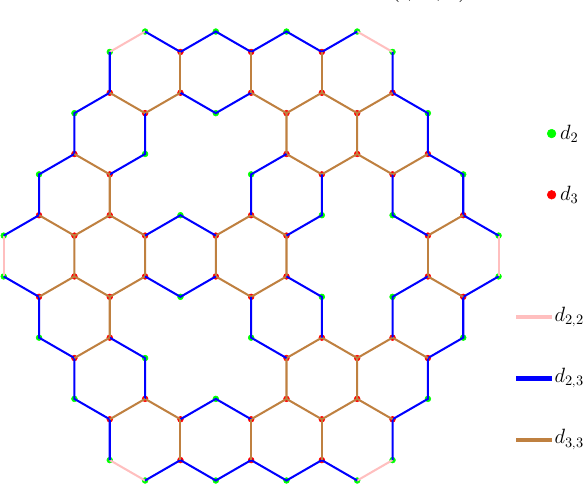
Figure 2: Zigzag - edge coronoid fused by starphene ZCS 4,4,4 ( ) .